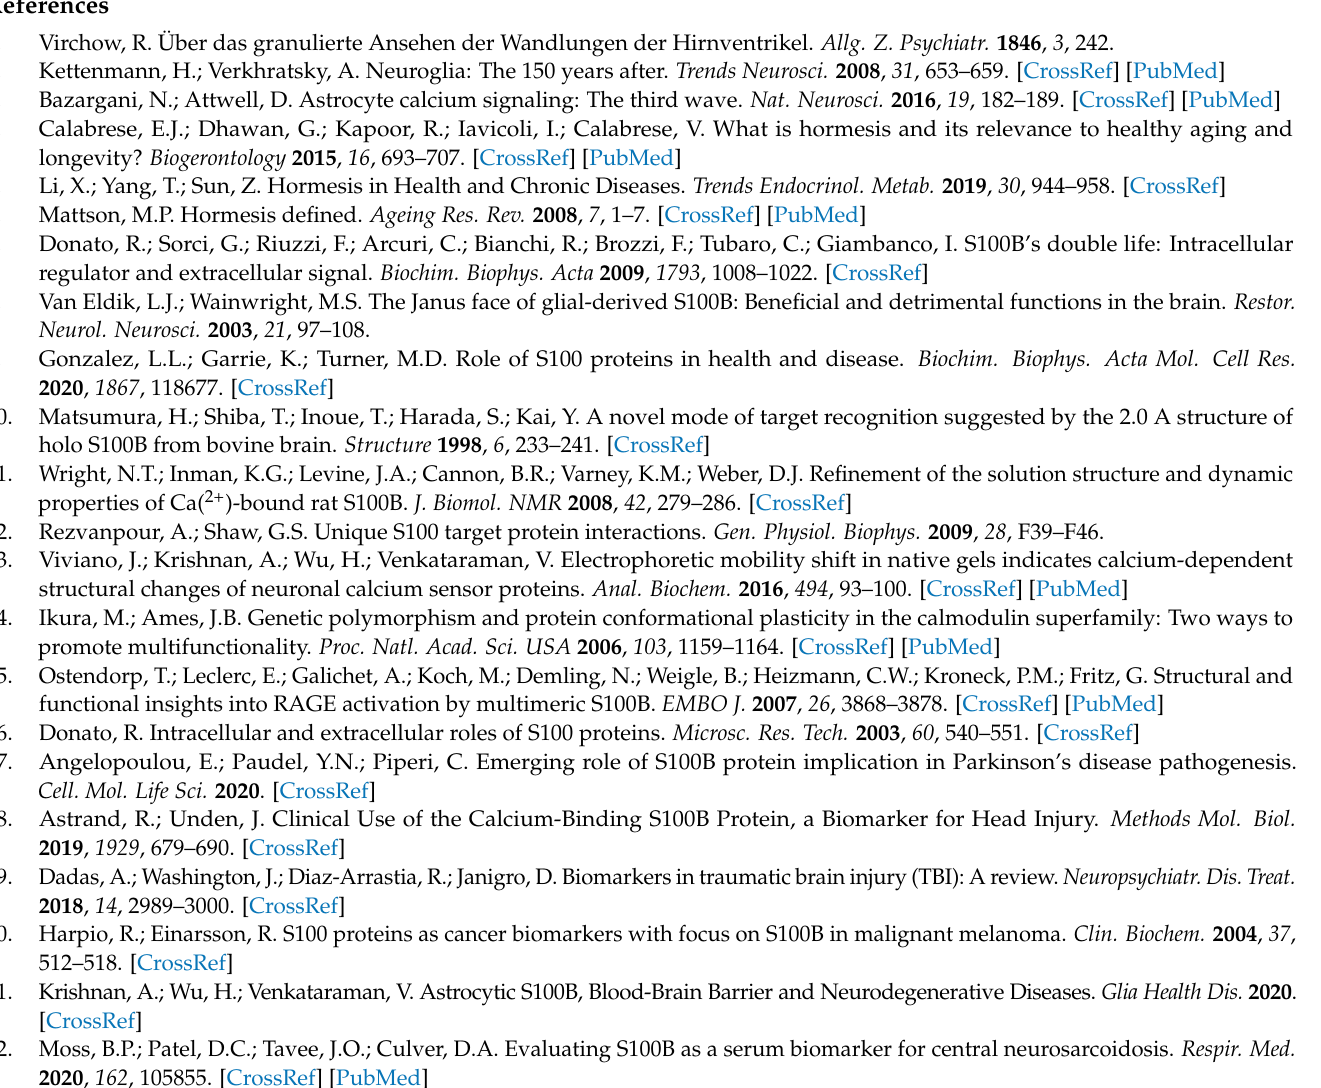
cation described in Figure 4, including Figure S1: Estimation by freehand line tool, Figure S2: Estimation by automated area